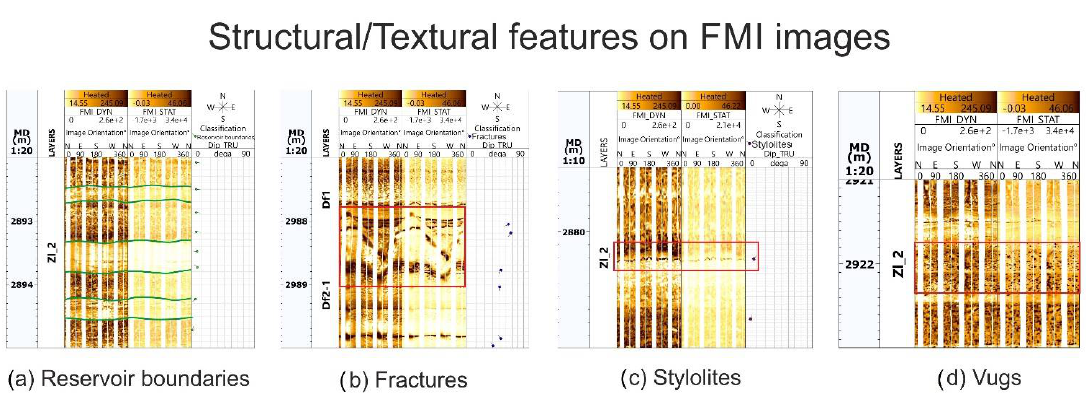
Figure 6. Example of features observed during the FMI interpretation. The green lines in ( a ) mark the boundaries between discrete layers. In ( b ), an open, conductive fracture is visible as a dark-colored sine wave between 2988 m and 2989 m, and an irregular, sub-horizontal stylolite is visible in ( c ). In image ( d ), the irregular dark patches are isolated vugs.